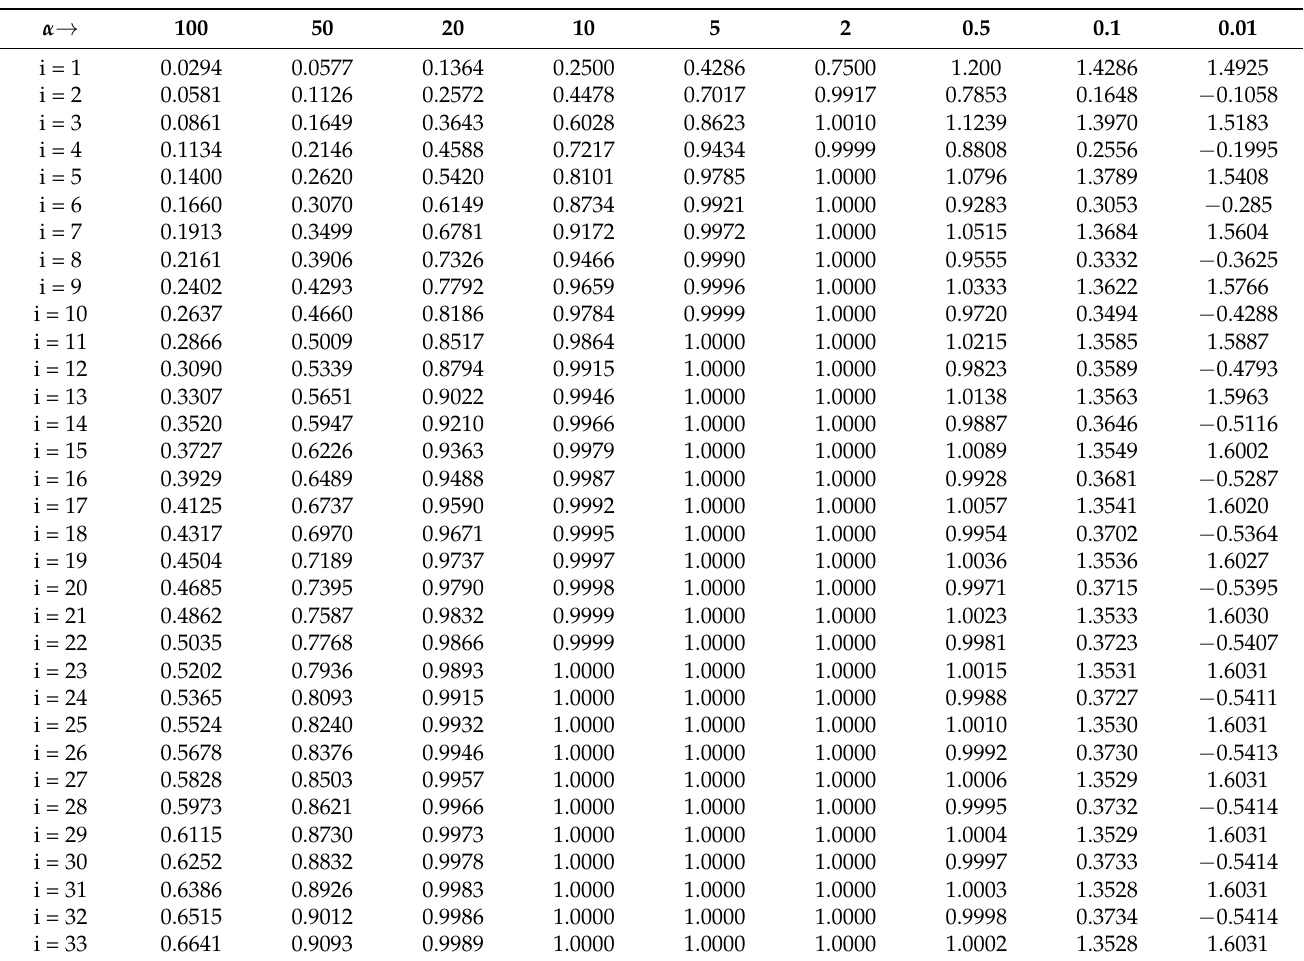
Table 1. The constant Ψ i obtained for nine different values of α